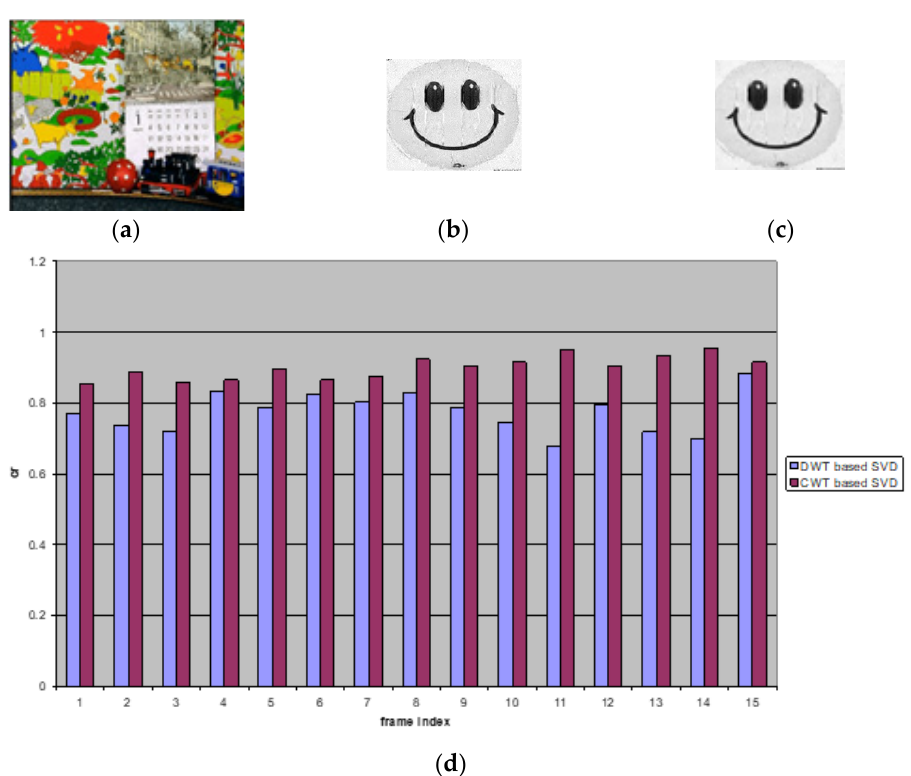
values for the extracted watermarks for frames 1 to 15 in the first video scene under histeq attacks.